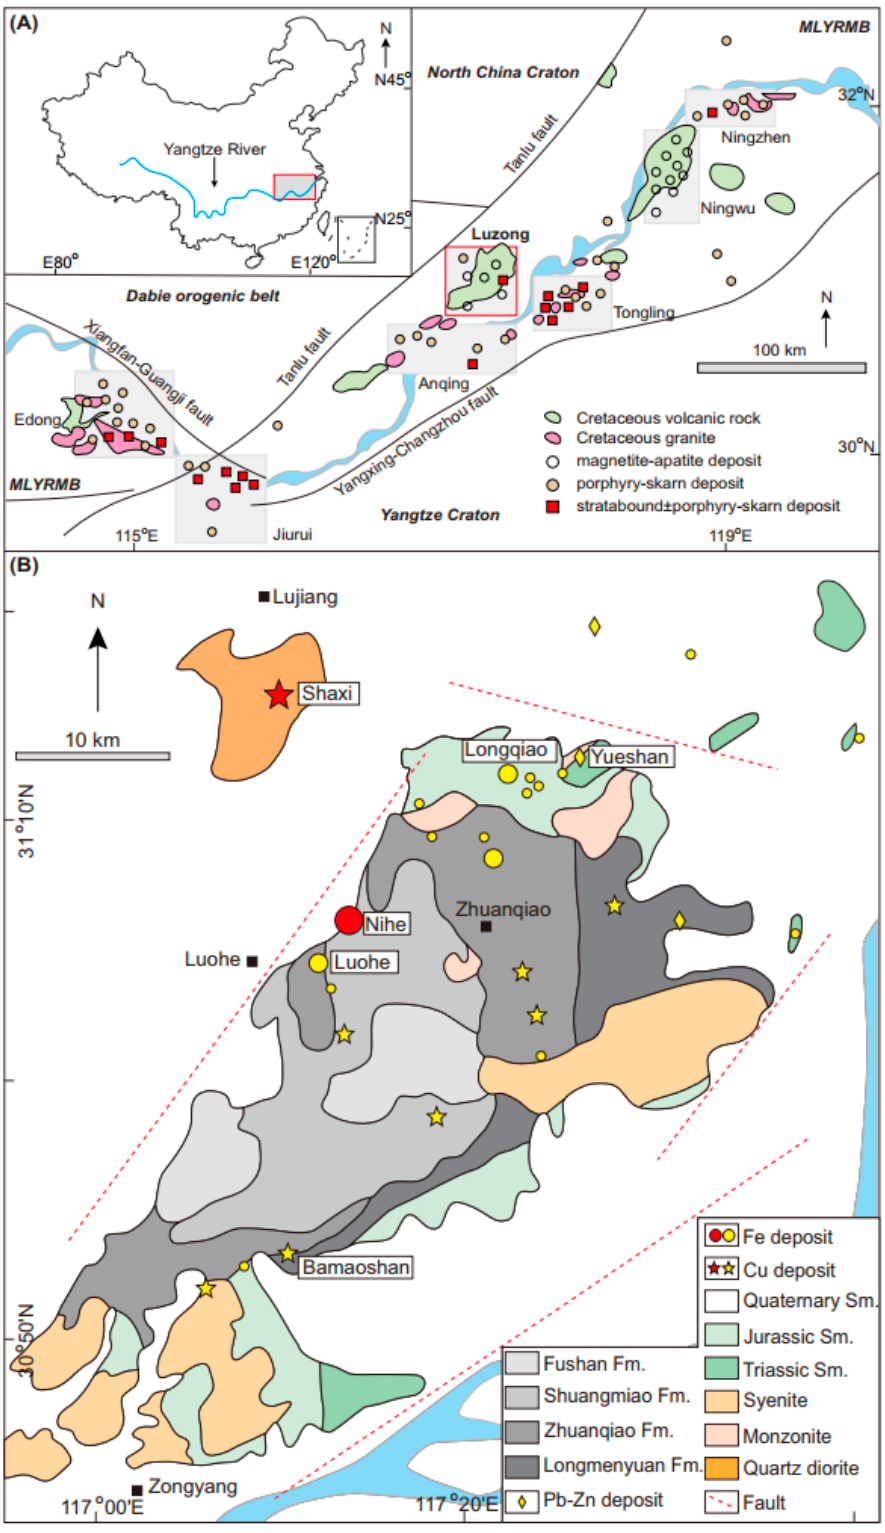
Figure 1. ( A ) Distribution of the major Cretaceous igneous rocks and mineral deposits in the Middle–Lower Yangtze River metallogenic belt, South China. The map is modified after Li et al. [31]. ( B ) Distribution of Fe, Cu, and Pb–Zn deposits including IOA (Nihe) and porphyry Cu–Au (Shaxi) in the Luzong basin modified after [17]. Abbreviations: Fm. = Formation; Sm. =